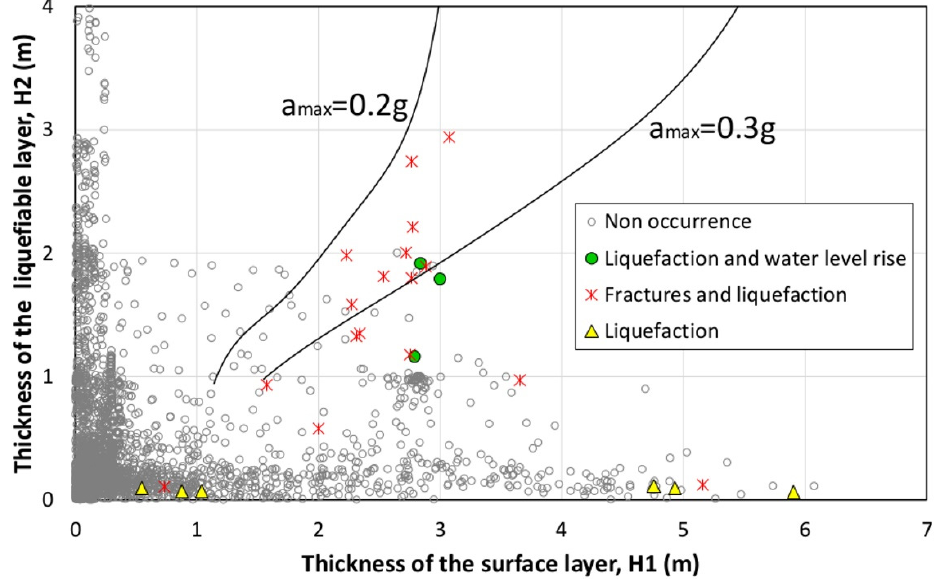
Figure 14. The thickness of liquefiable (H2) versus the thickness of the non-liquefiable (H1) layers for Cavezzo distinguishing the non-occurrence points and ground surface manifestations of liquefaction. The bounds introduced by Ishihara (1985) [6] are also